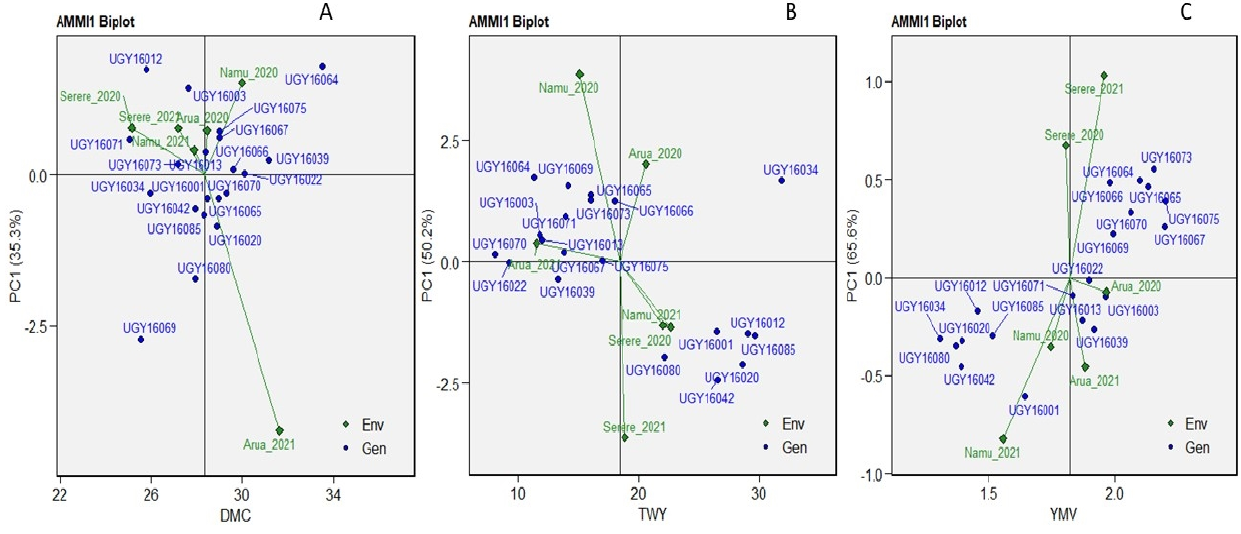
Figure 3. AMMI1 biplot for mean dry matter content ( A ), the total weight of tubers ( B ), yam mosaic virus ( C ), and their respective PC 1 scores for 20 yam genotypes evaluated in six environments. Table 10. Genotype means for traits, stability index (IPCA 1), and ranking across six test environments in